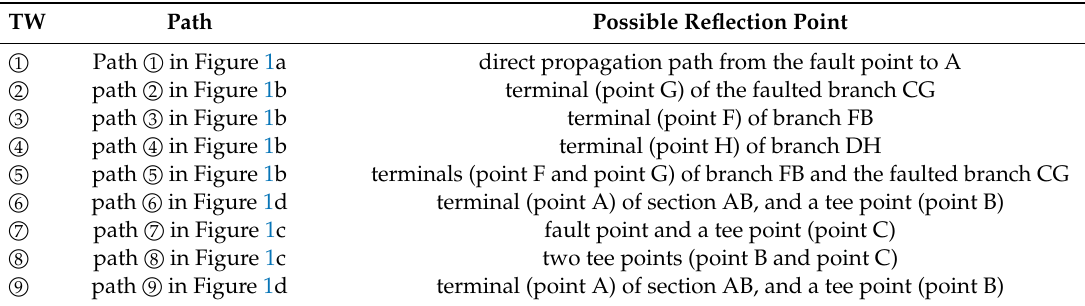
Table 1. TW Propagation